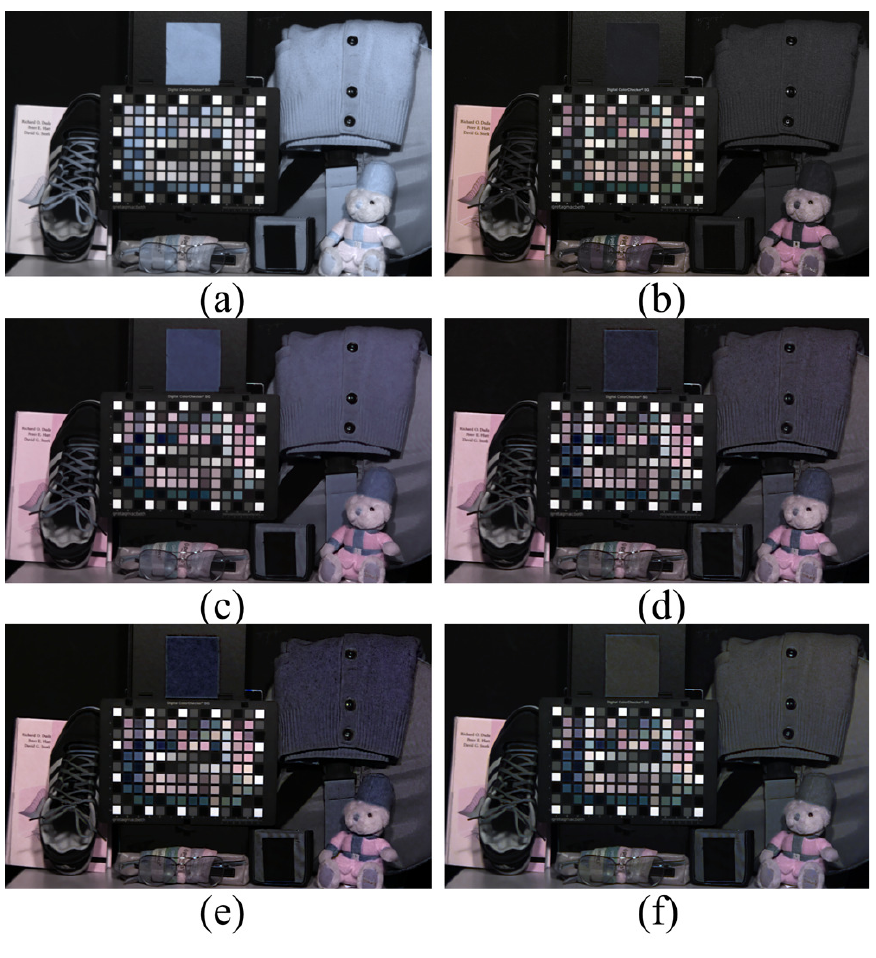
Figure 21. Experimental results under an incandescent lamp (1 lx) ( a ) Input image; ( b ) optical filtered visible band image; ( c ) 3 × 3 CCM; ( d ) 3 × 4 CCM; ( e ) root-polynomial mapping; ( f ) proposed method.